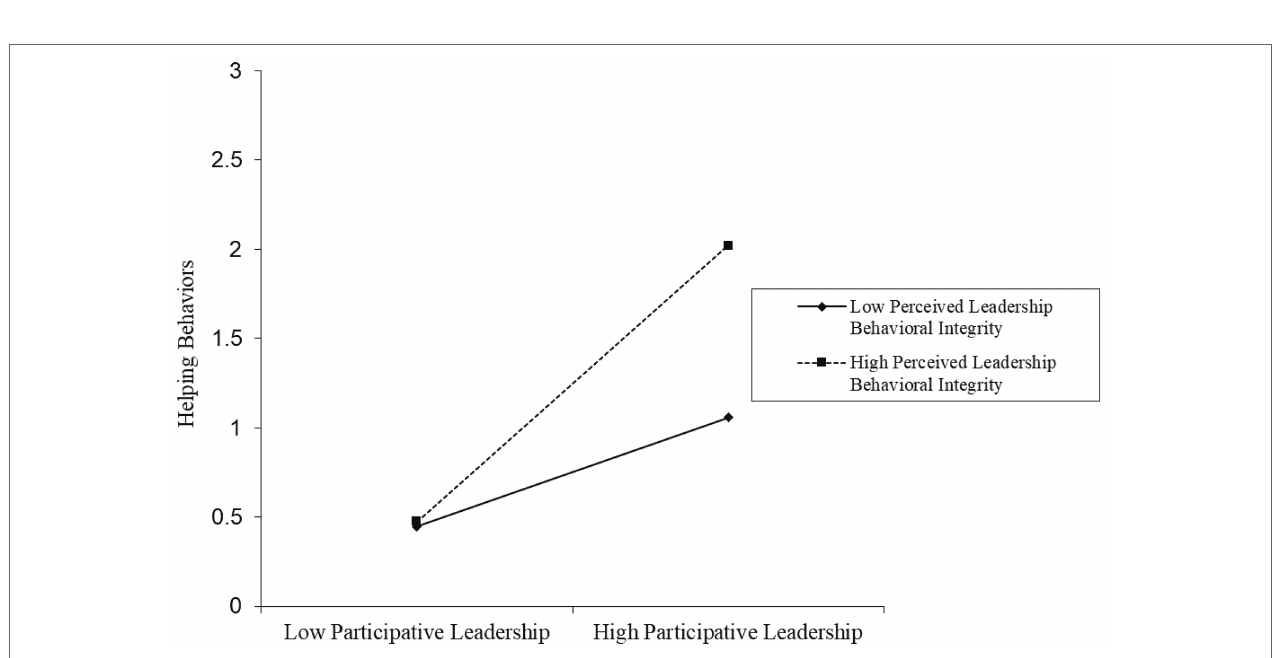
FIGURE 2 | Moderating effect of perceived leadership behavioral integrity between the relationship of participative leadership and workplace thriving.